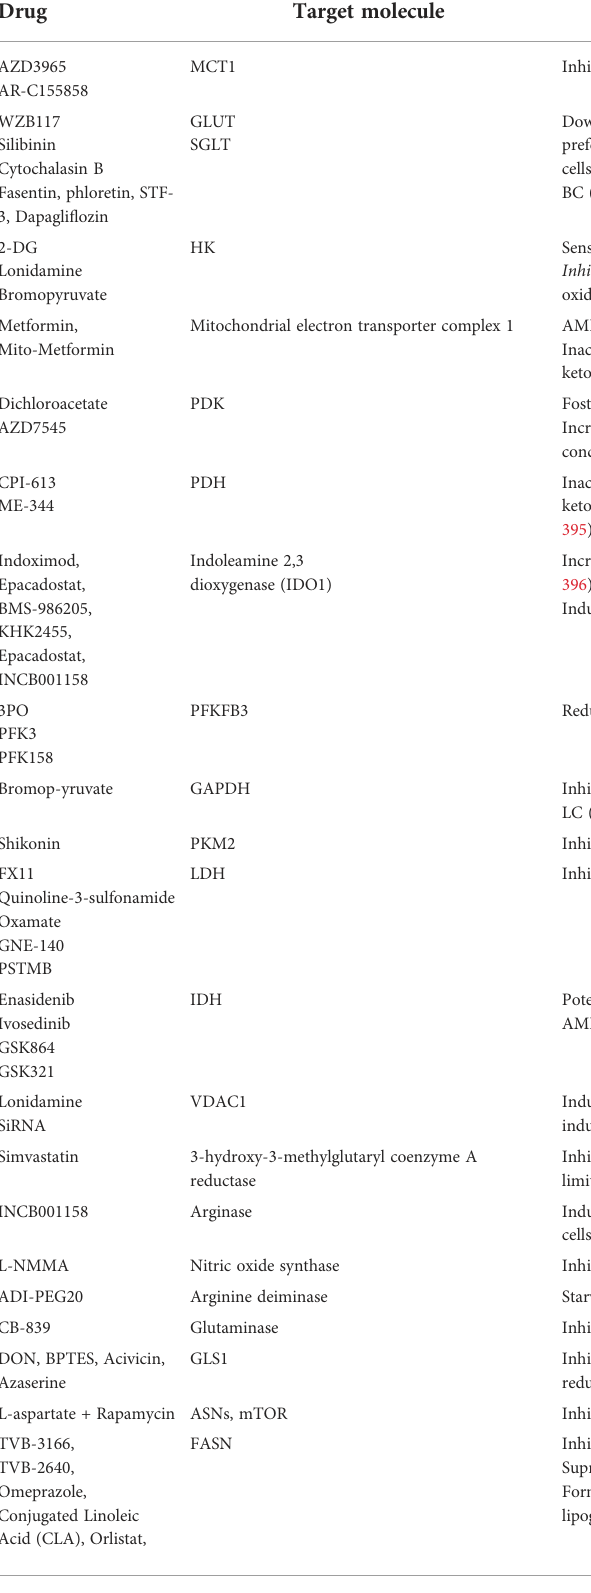
TABLE 1 List of metabolic pathway drugs which were evaluated clinically.